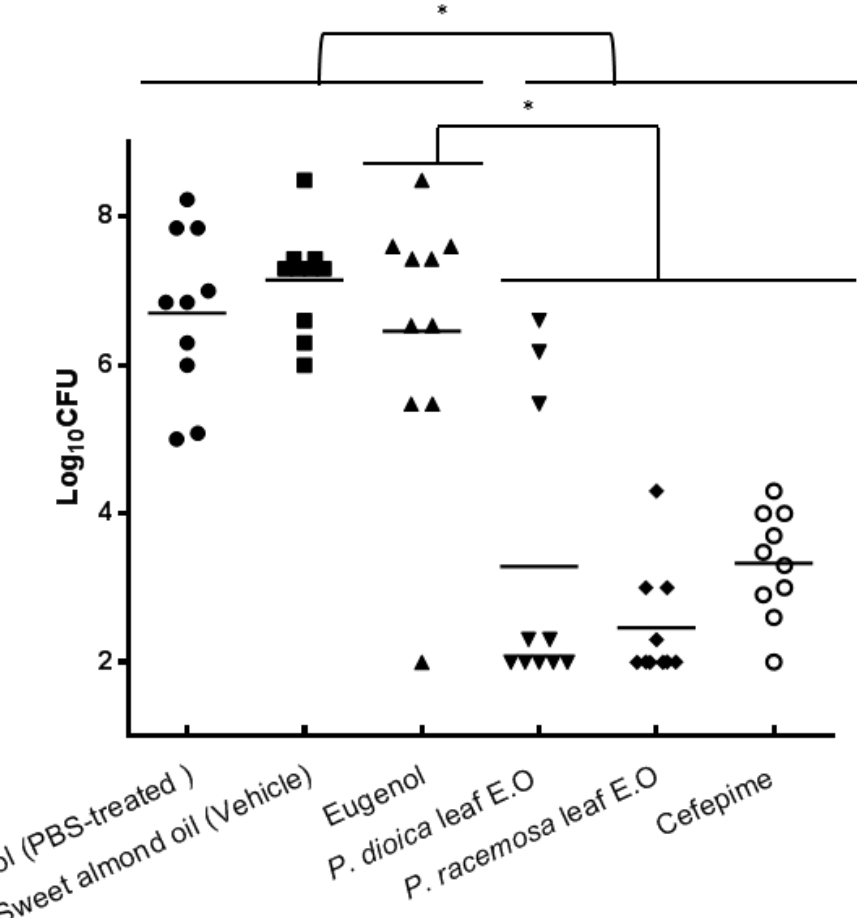
Figure 4. The antimicrobial e ff ect of Pimenta dioica and Pimenta racemosa leaf essential oils and eugenol at 5.2 µ g · mL − 1 (10 × MIC) concentration and cefepime at 25 µ g · g − 1 of mouse weight, tested against AB-8 isolate in a skin wound infection mouse model. Data is represented by the mean colony counts recovered from each of the six infected groups ± SD, six days post-infection. ( • ) data points of control infected PBS-treated group, ( (cid:4) ) data points of sweet almond-treated group (negative (vehicle) control group), ( (cid:78) ) data points of eugenol-treated group, ( (cid:72) ) data points of P. dioica leaf E.O-treated group, ( ) data points of P. racemosa leaf E.O-treated group, ( ) data points of cefepime-treated group (positive drug control group). n = 10 mice per group. (One-way ANOVA followed by Tukey’s multiple comparisons test, p -value = 0.0047). (*) Means statistically significant di ff erence exists between groups.